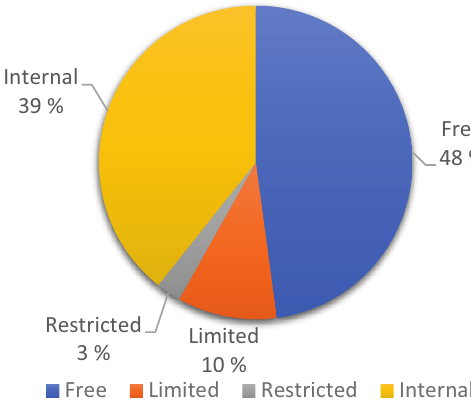
Figure 6. Data openness.